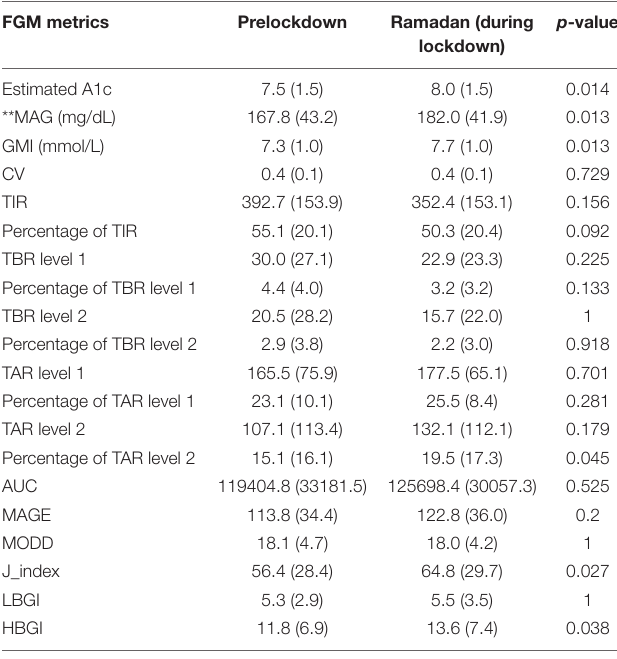
TABLE 3 | Comparison of FGM metrics during *prelockdown and Ramadan during